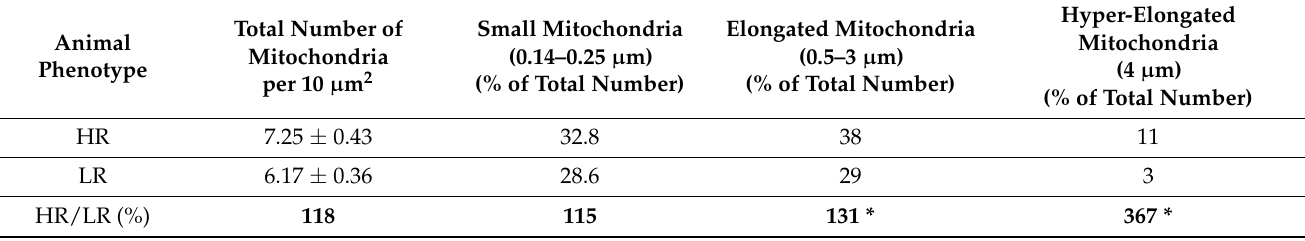
Table 2. Differences in morphometric values of mitochondria from cerebral cortex (CC) of high-resistance (HR) and low-resistance (LR) rats in normoxia.